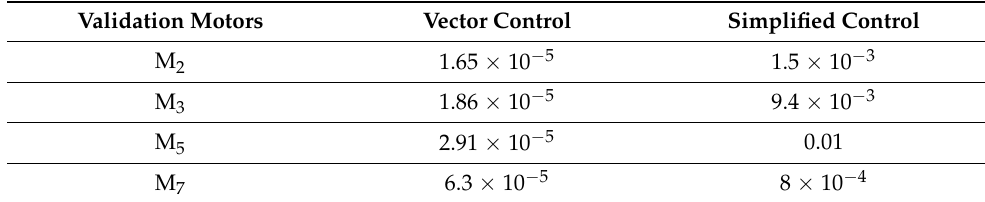
Table 2. Comparison of average rotor speed error (%).